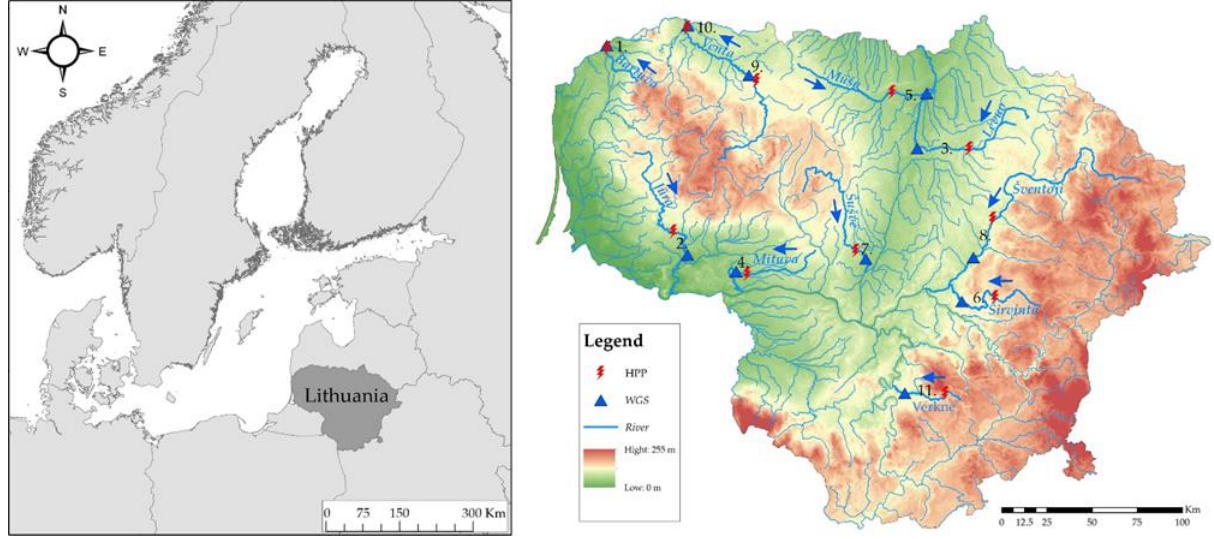
Figure 1. Study area.